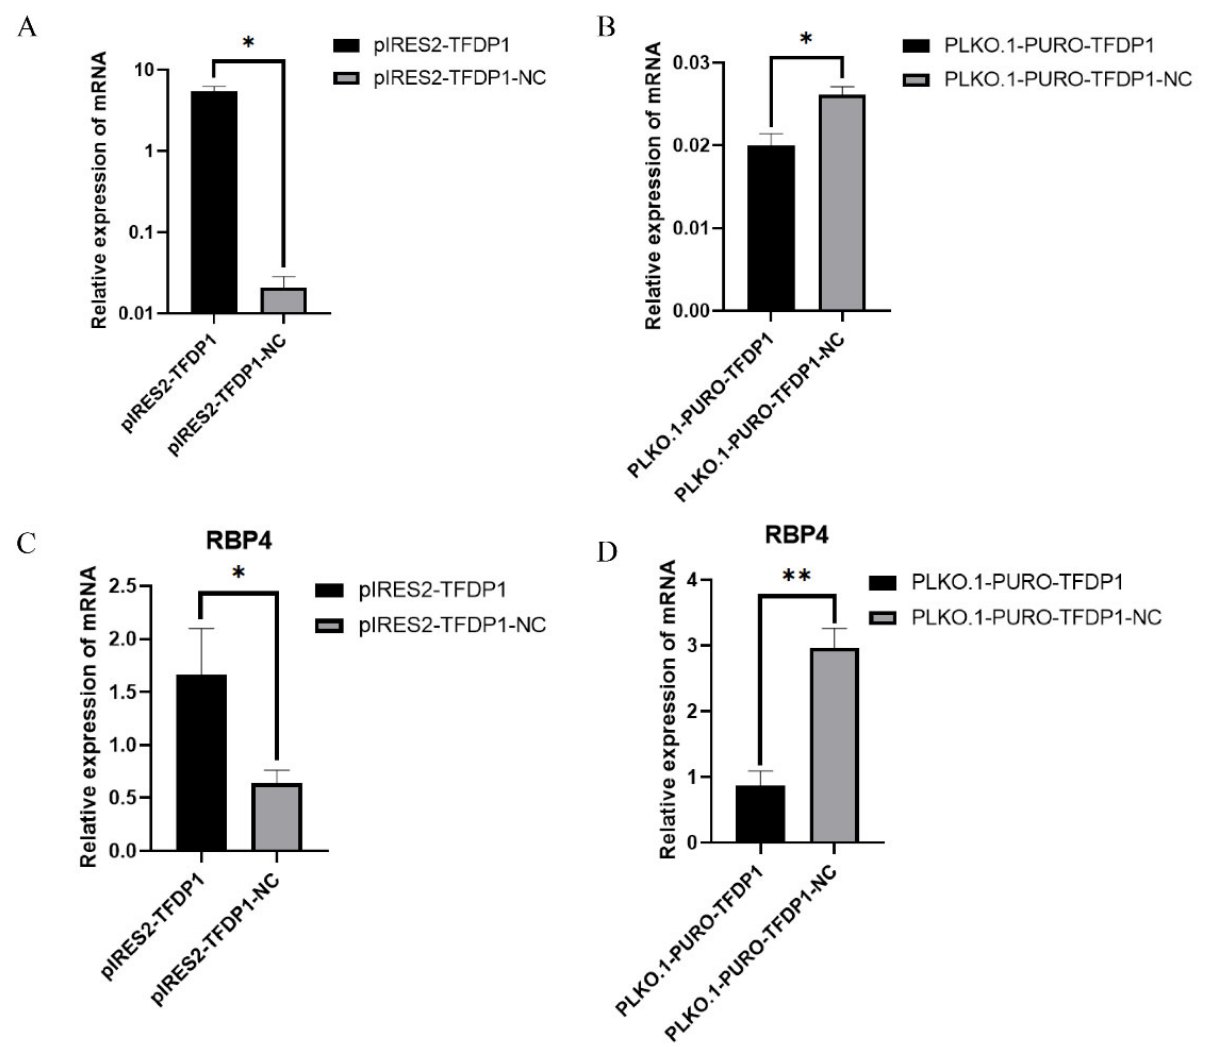
Figure 5. ( A , B ): The expression of TFDP1 in goat GCs after TFDP1 overexpression and interference. ( C , D ): The expression of RBP4 in goat GCs after TFDP1 overexpression and interference. The results were expressed as the mean ± SEM ( n = 3). * p < 0.05; ** p < 0.01.